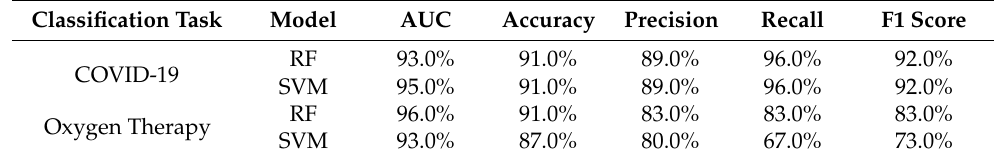
Figure 6. ROC curve of the SVM model for COVID-19 classification (on the left ) and ROC curve of the RF model for COVID-19 classification (on the right ). Table 3. Test set classification results.